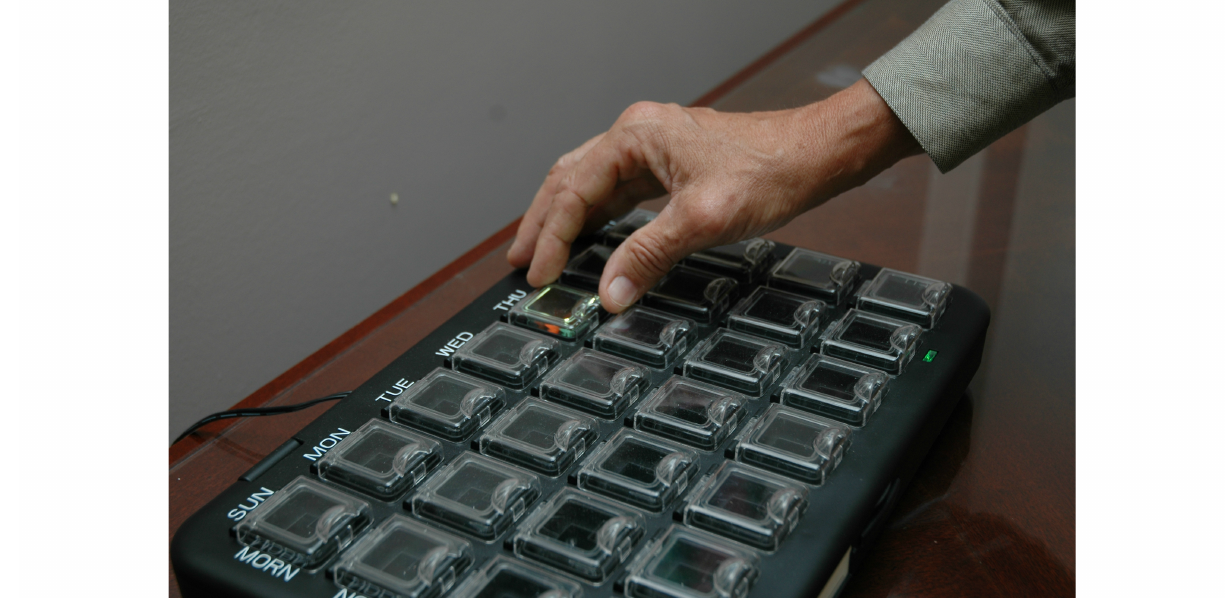
Figure 1. Electronic medication tray